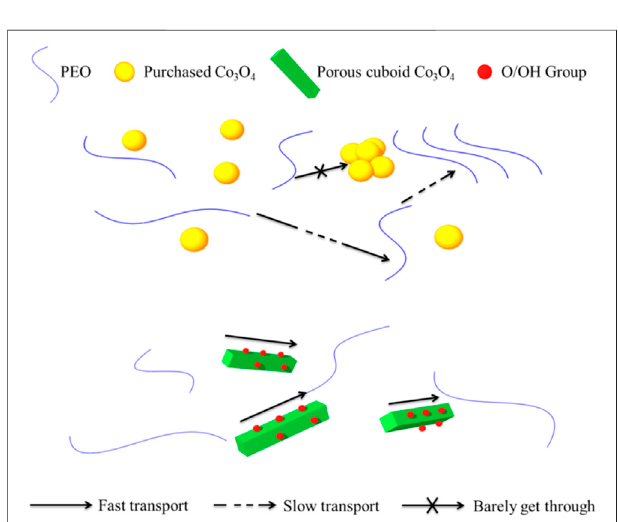
Frontiers in Materials |